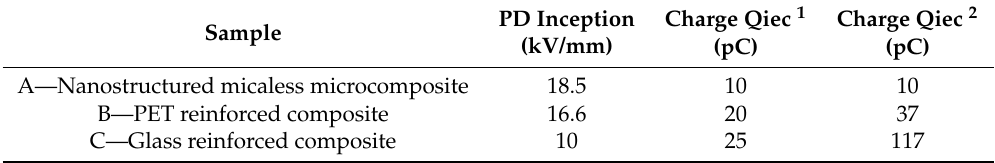
Table 4. Charge Qiec and PDs inception levels for investigated